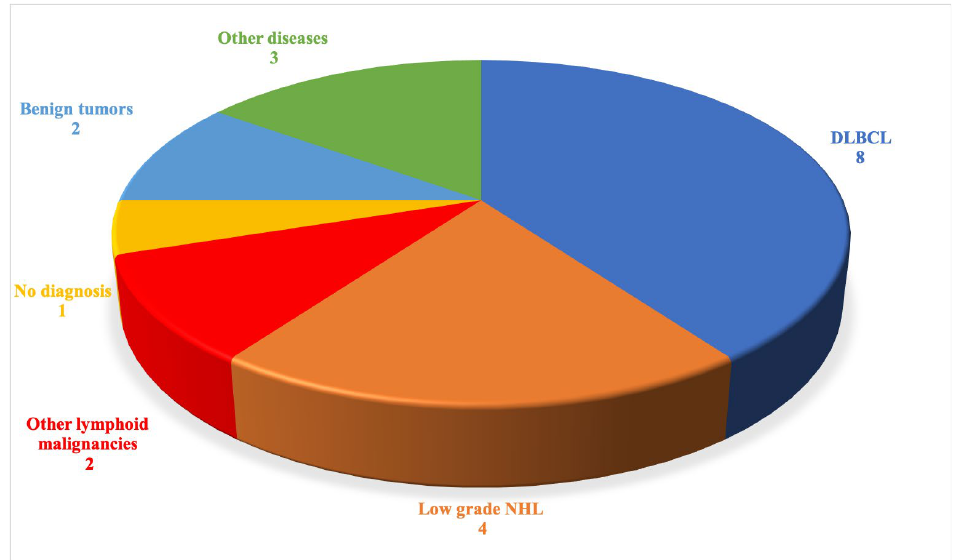
Figure 2. Identified pathologies (represented as the absolute number of